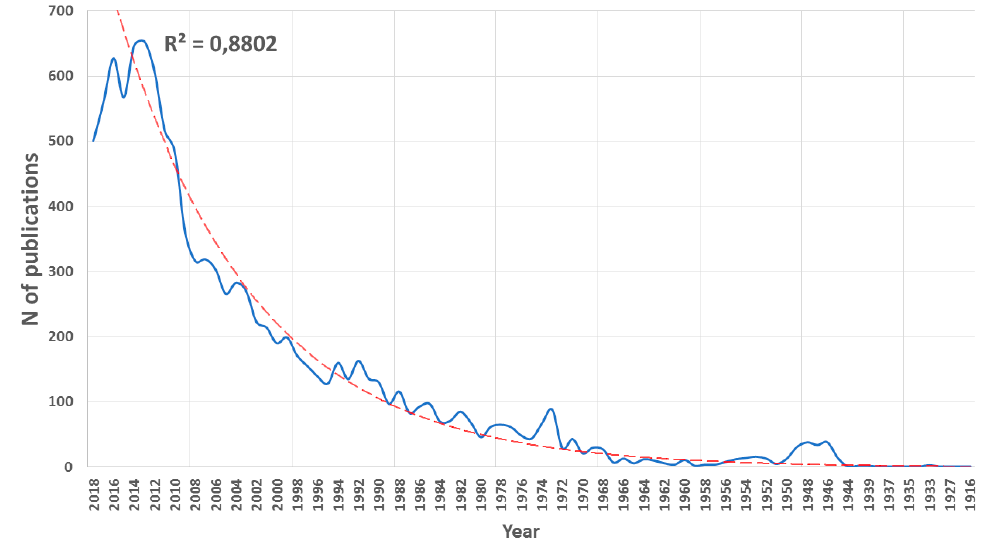
Figure 2. The trend of the number of publications in malaria and Plasmodium vivax , from the years 1916–2018.